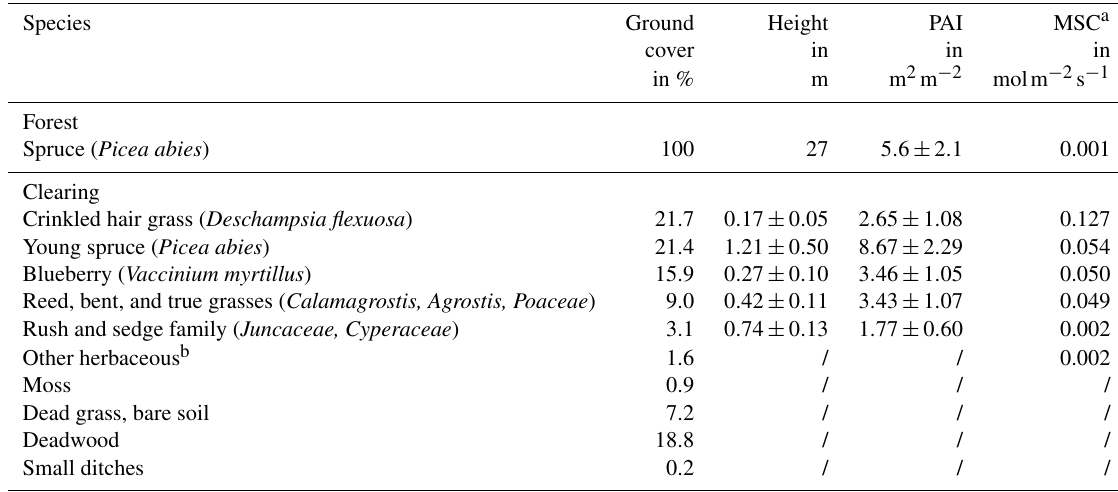
cover in in in in % m m 2 m − 2 molm − 2 s − 1